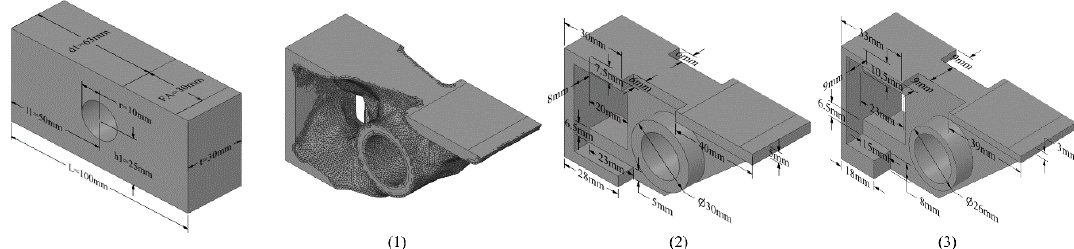
Figure 9. The three design processes in the TO workflow: (1) Topology optimization with no redesign (TO_NR), (2) topology optimization with redesign (TO_R), and (3) topology optimization with redesign and parametric shape optimization (TO_R_PO).